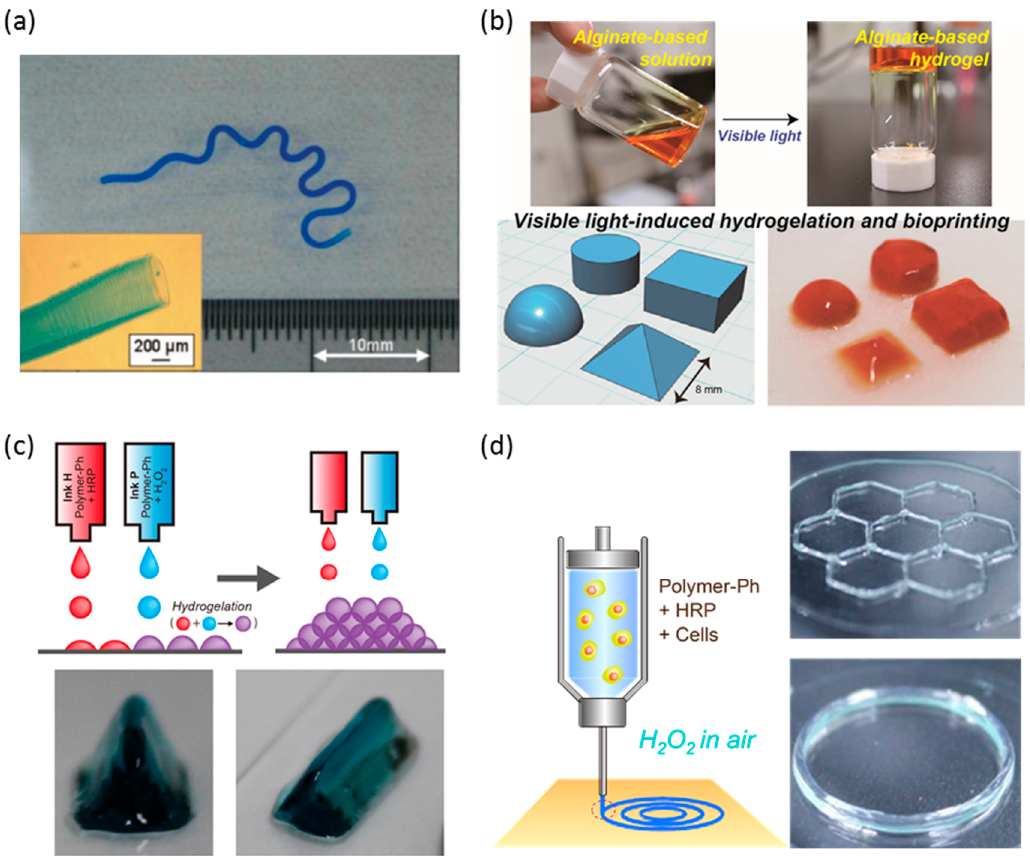
Figure 5 . (a) Ca-alginate tube prepared through inkjet bioprinting, and hydrogel constructs